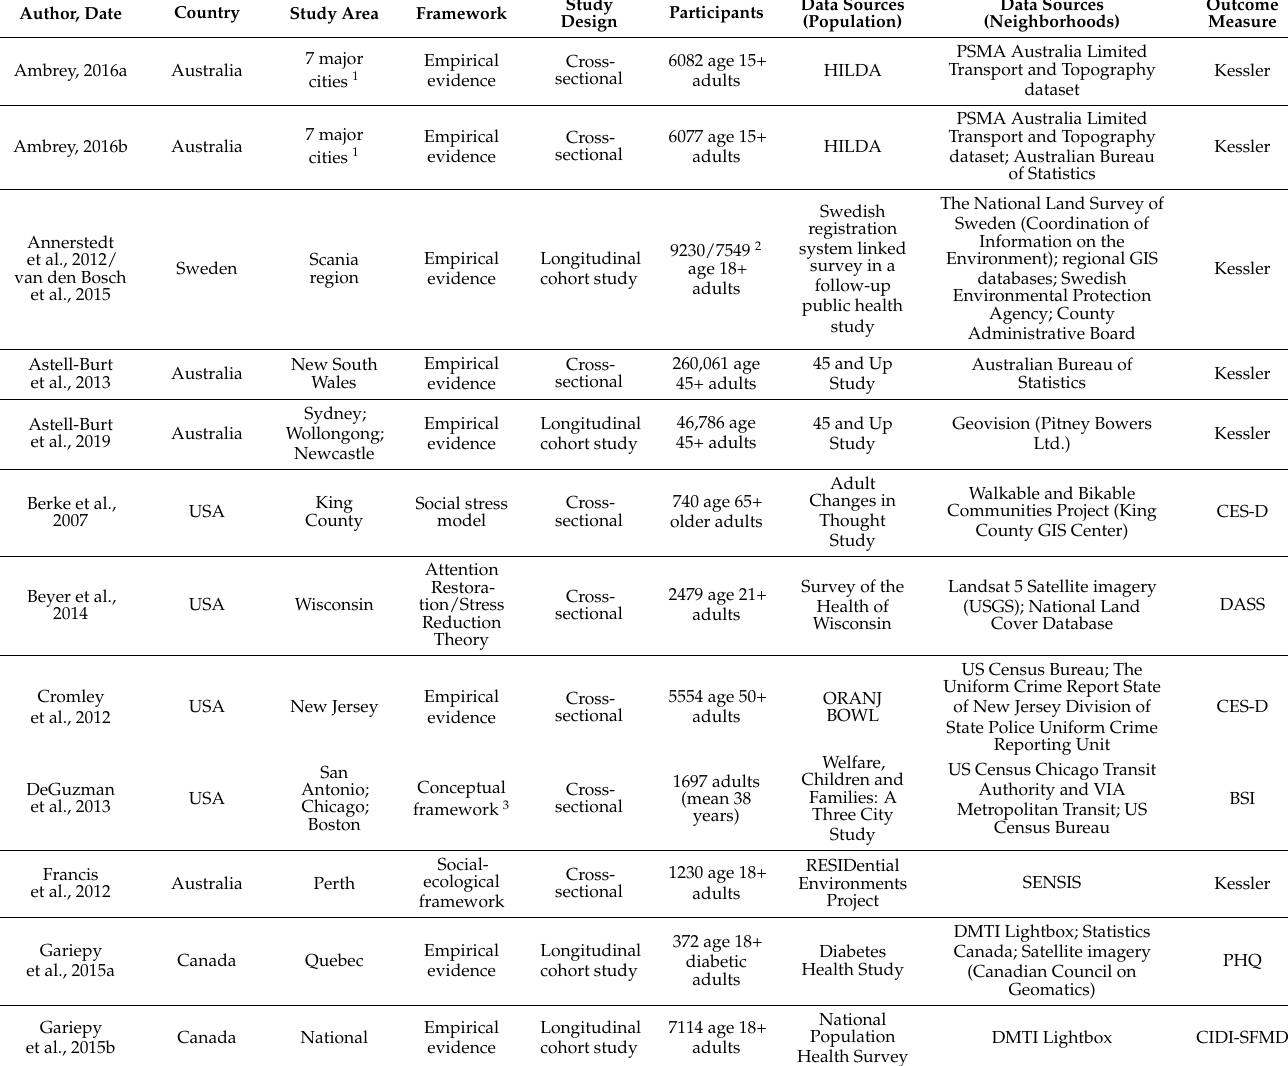
Table 2. Characteristics of included